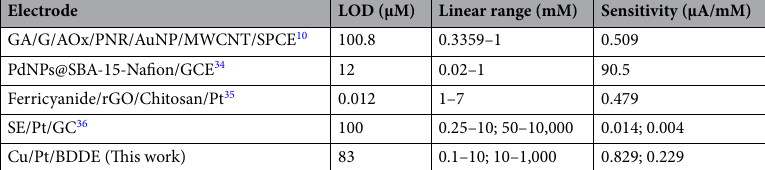
Table 1. Comparison of the analytical performance of other modified electrodes in the literature reports.